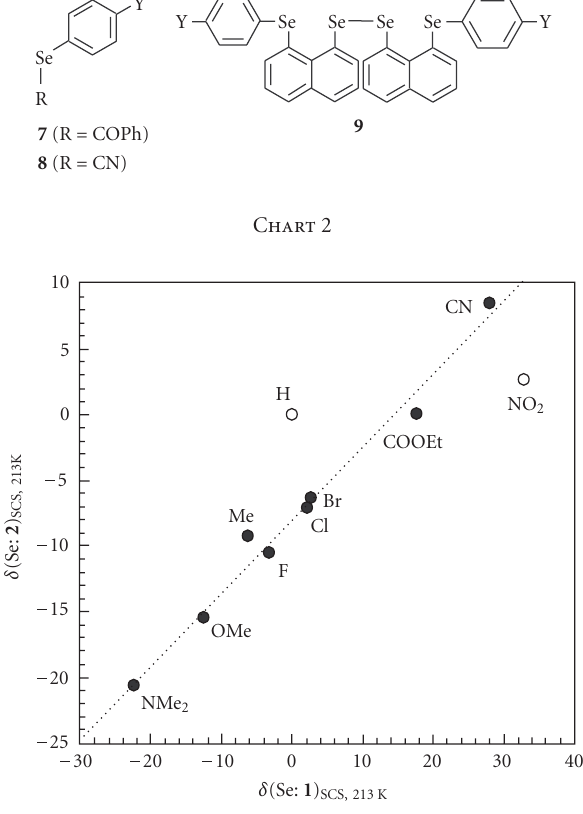
Figure 1: Plot of δ (Se: 2 ) SCS, 213K versus δ (Se: 1 ) SCS, 213K .